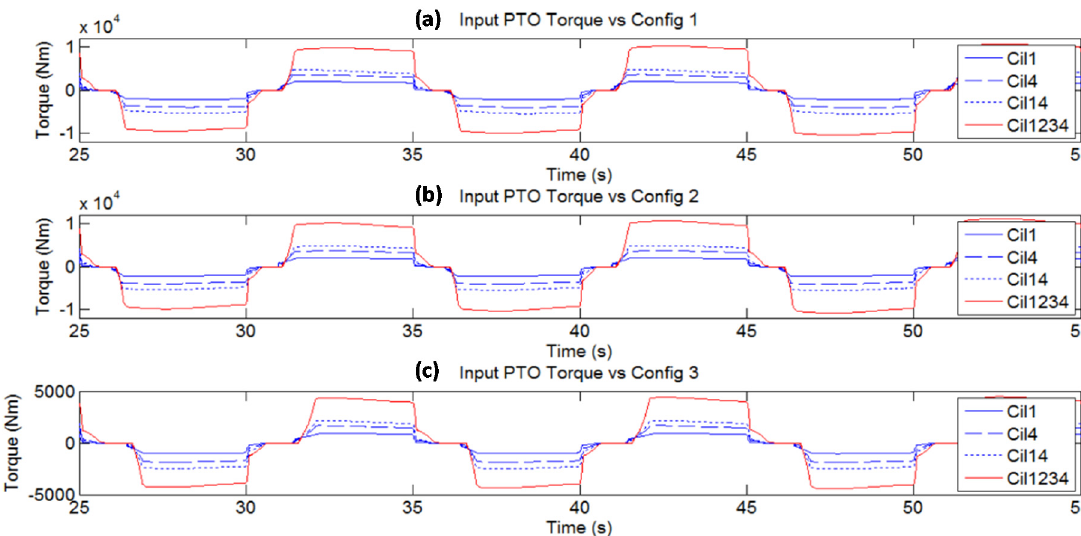
Figure 15. Restraining Torque Evolution at the PTO input. Comparison between different Geometrical configurations using same activated hydraulic cylinders. ( a ) Config 1; ( b ) Config 2; ( c ) Config